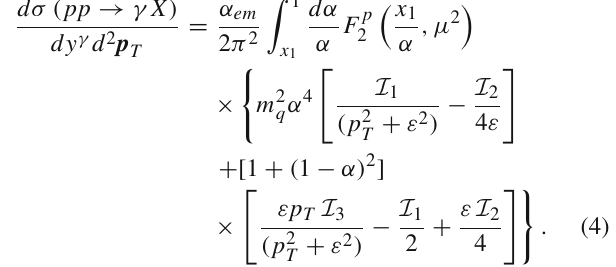
in terms of q ¯ q dipole scattering off the